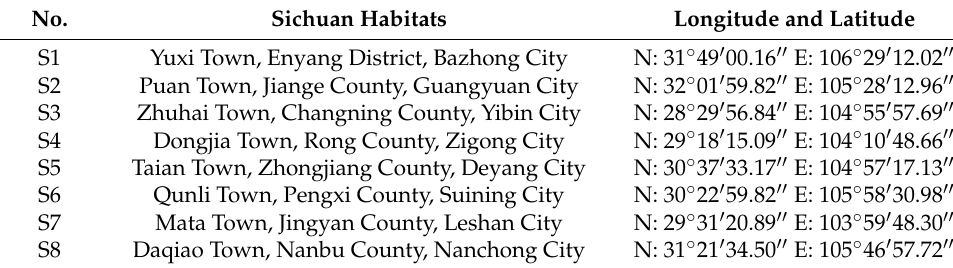
Table 3. Information of Lysimachiae Herba samples from eight different habitats. No. Sichuan Habitats Longitude and Latitude S1 N: 31 ◦ 49 (cid:48) 00.16 (cid:48)(cid:48) E: 106 ◦ 29 (cid:48) 12.02